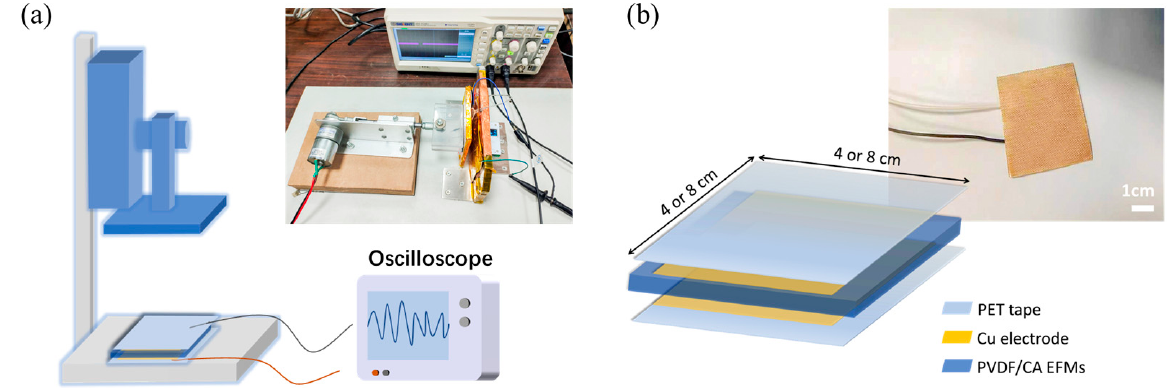
Figure 1. ( a ) The test apparatus; ( b ) schematical illustrations of the structure of the PVDF/CA PENG.